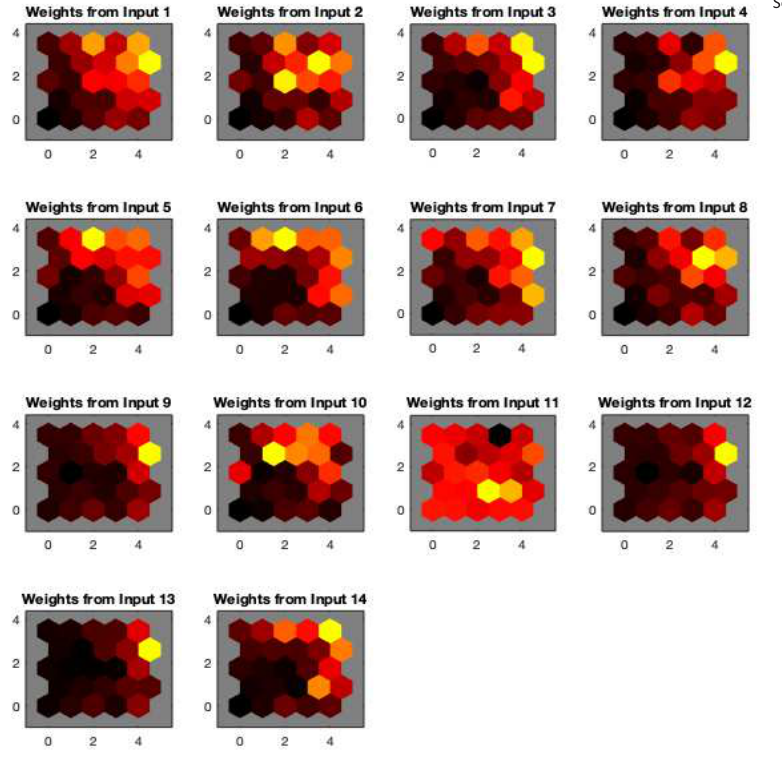
Figure 7. Mutual dependence of the individual predictors